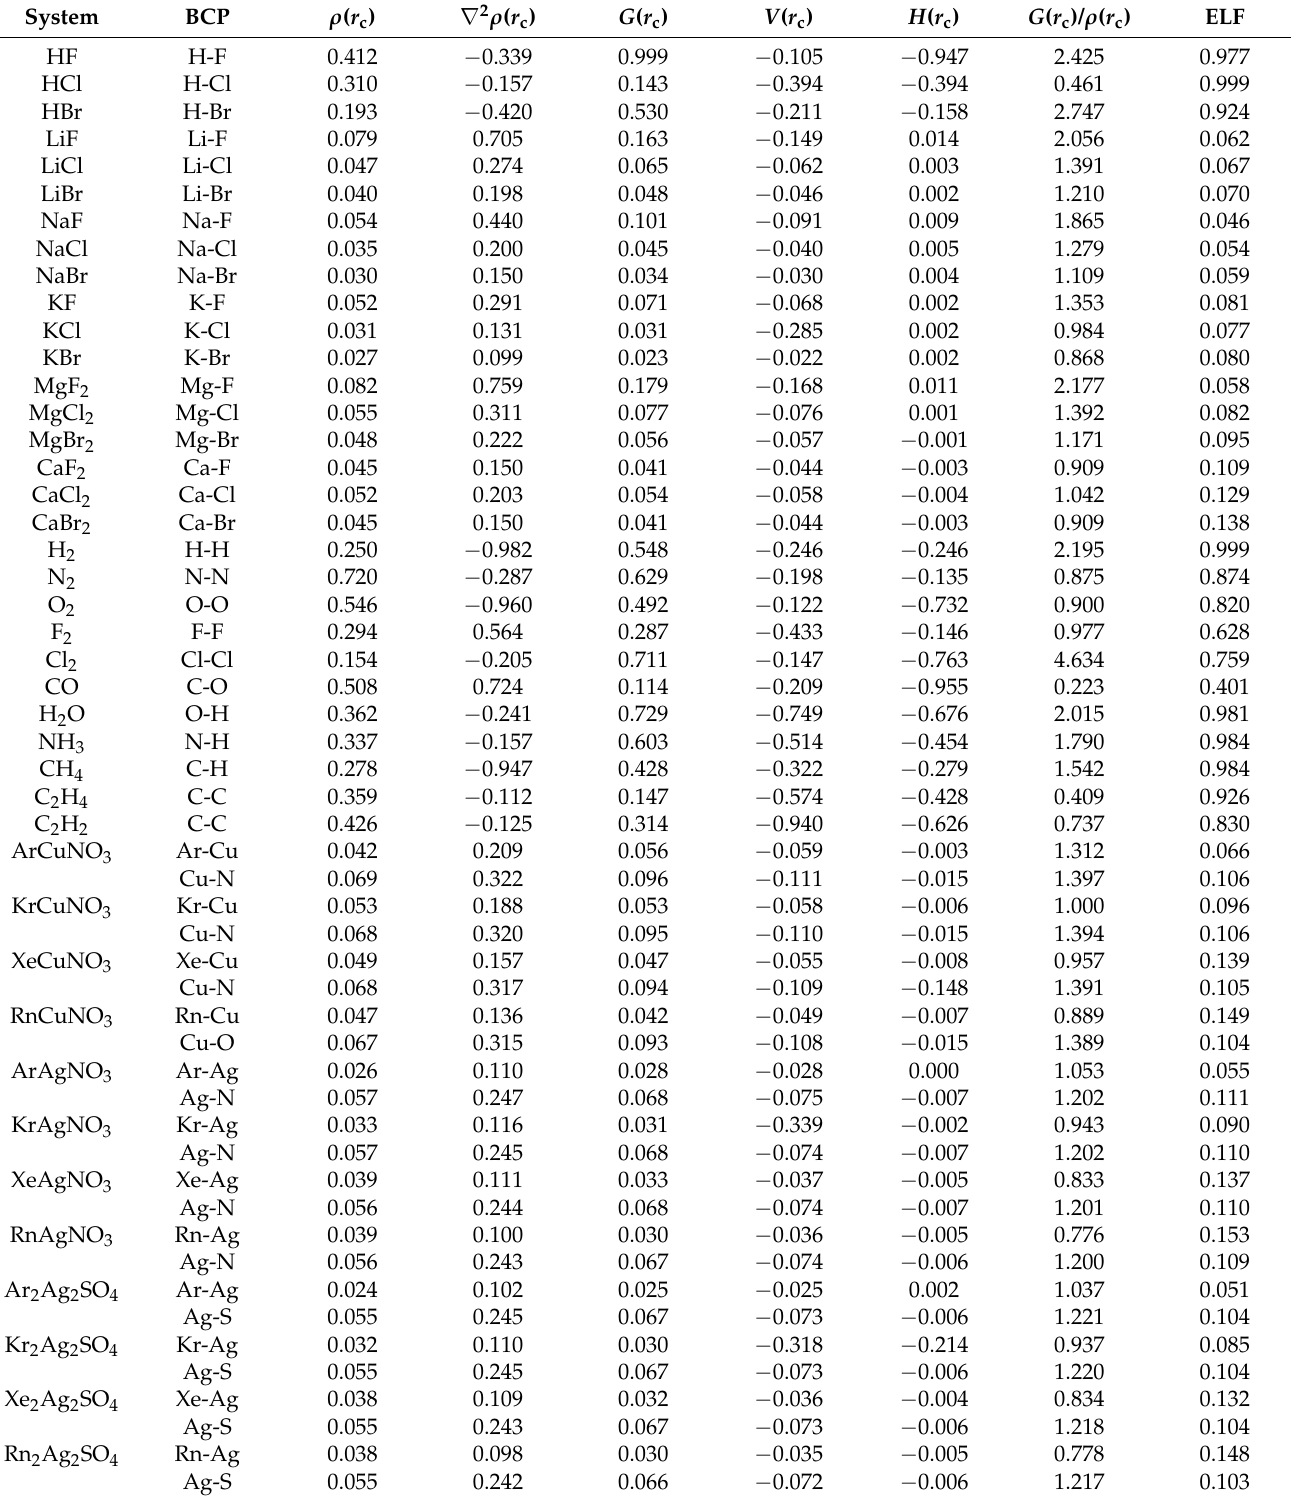
Table 1. Electron density descriptors calculated at the BCPs of the concerned bonds [Reprinted from Ref. [71] with permission from Springer Nature. © 2022, Indian Academy of